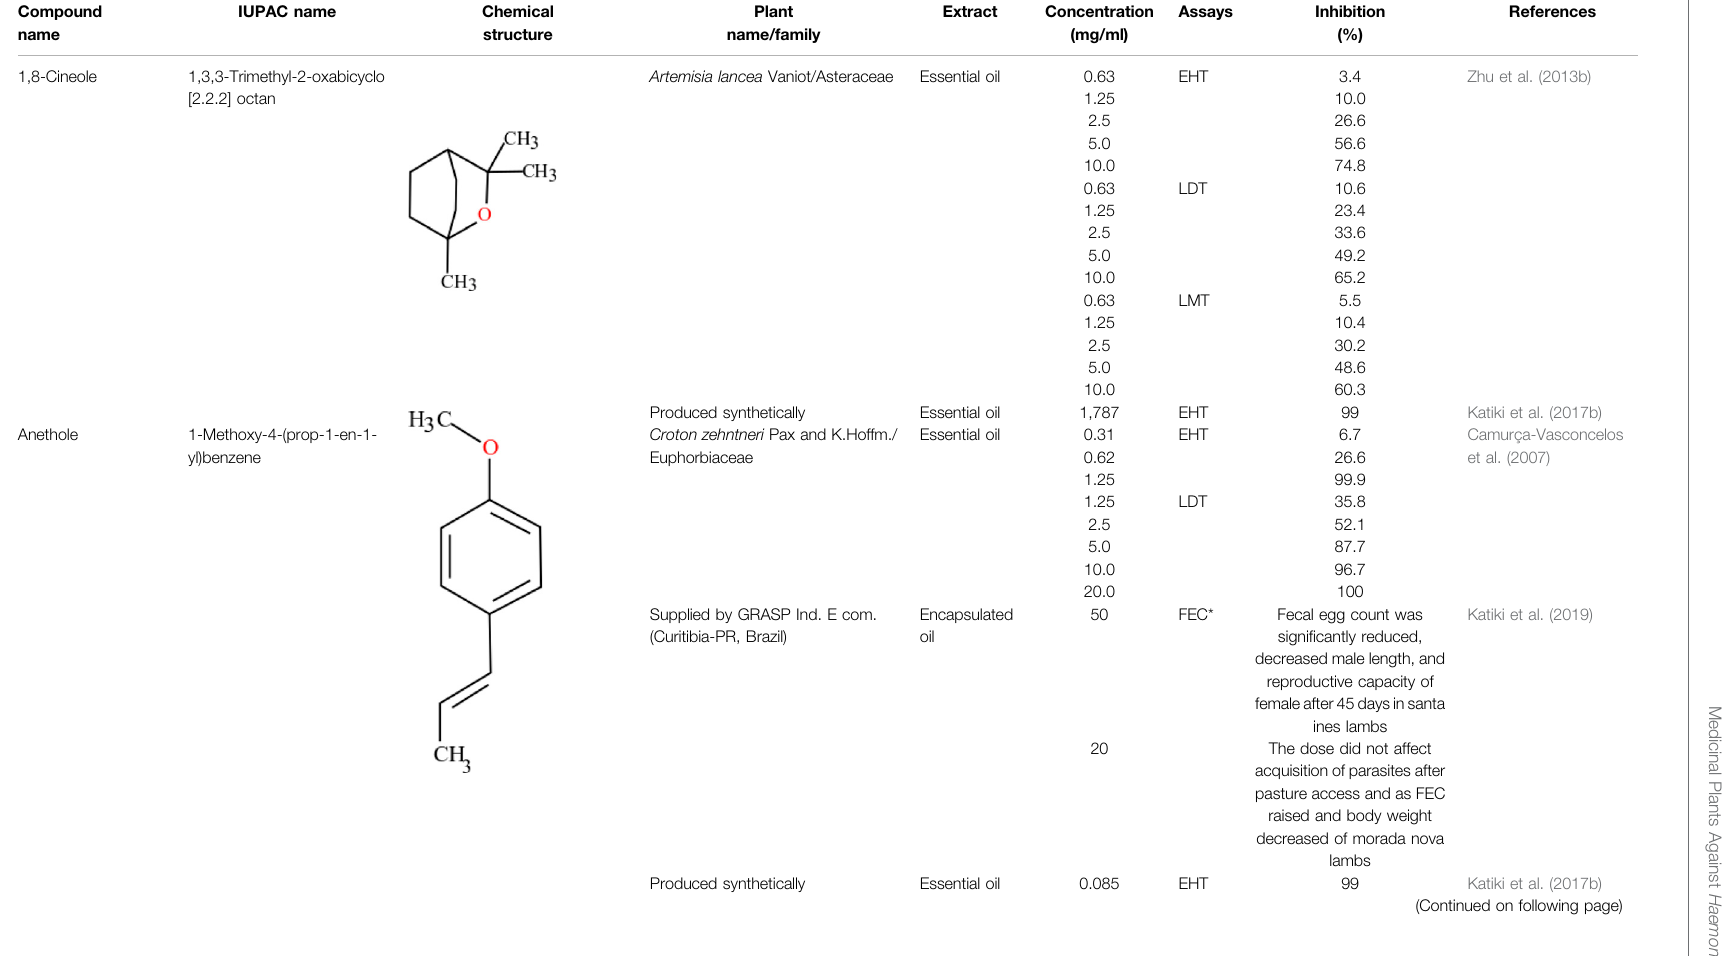
TABLE 3 | Plant compounds ef fi cacy against H. contortus